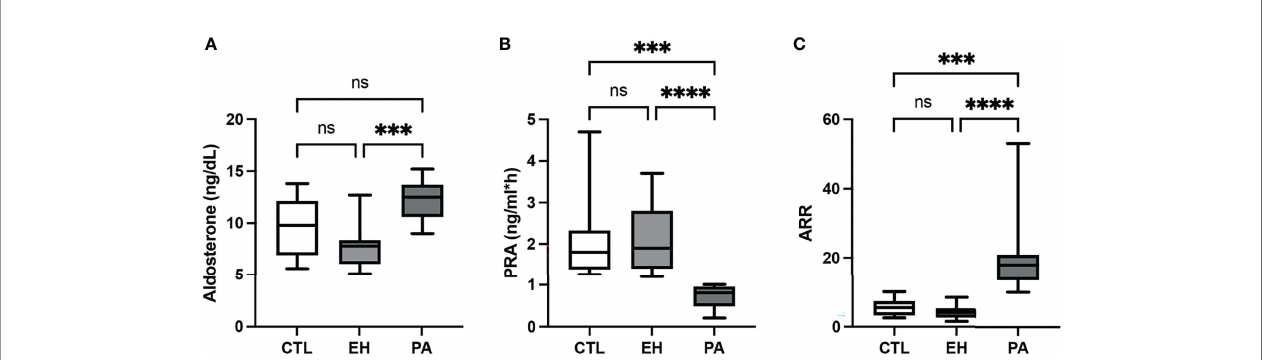
FIGURE 2 | Biochemical characteristics of subjects with PA. (A) Serum aldosterone concentration (ng/dL). Serum aldosterone levels were higher in PA subjects in the EH group. (B) Plasmatic renin activity (PRA; ng/mL*h). Plasmatic renin activity was lower in PA subjects in both the EH and CTL groups. (C) Aldosterone to renin ratio (ARR). ARR was higher in PA subjects in both the EH and CTL groups. Comparison between groups was performed by unpaired one-way ANOVA or Kruskal- Wallis test. Data are presented as median and interquartile range [Q1-Q3], N.S, No signi fi cative difference; ***p < 0.001, ****p <